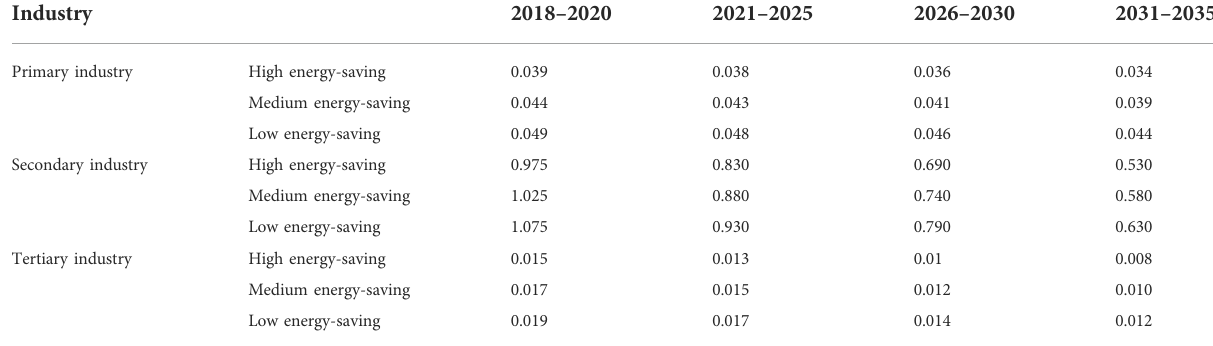
TABLE 9 Coal consumption intensity setting under different scenarios.